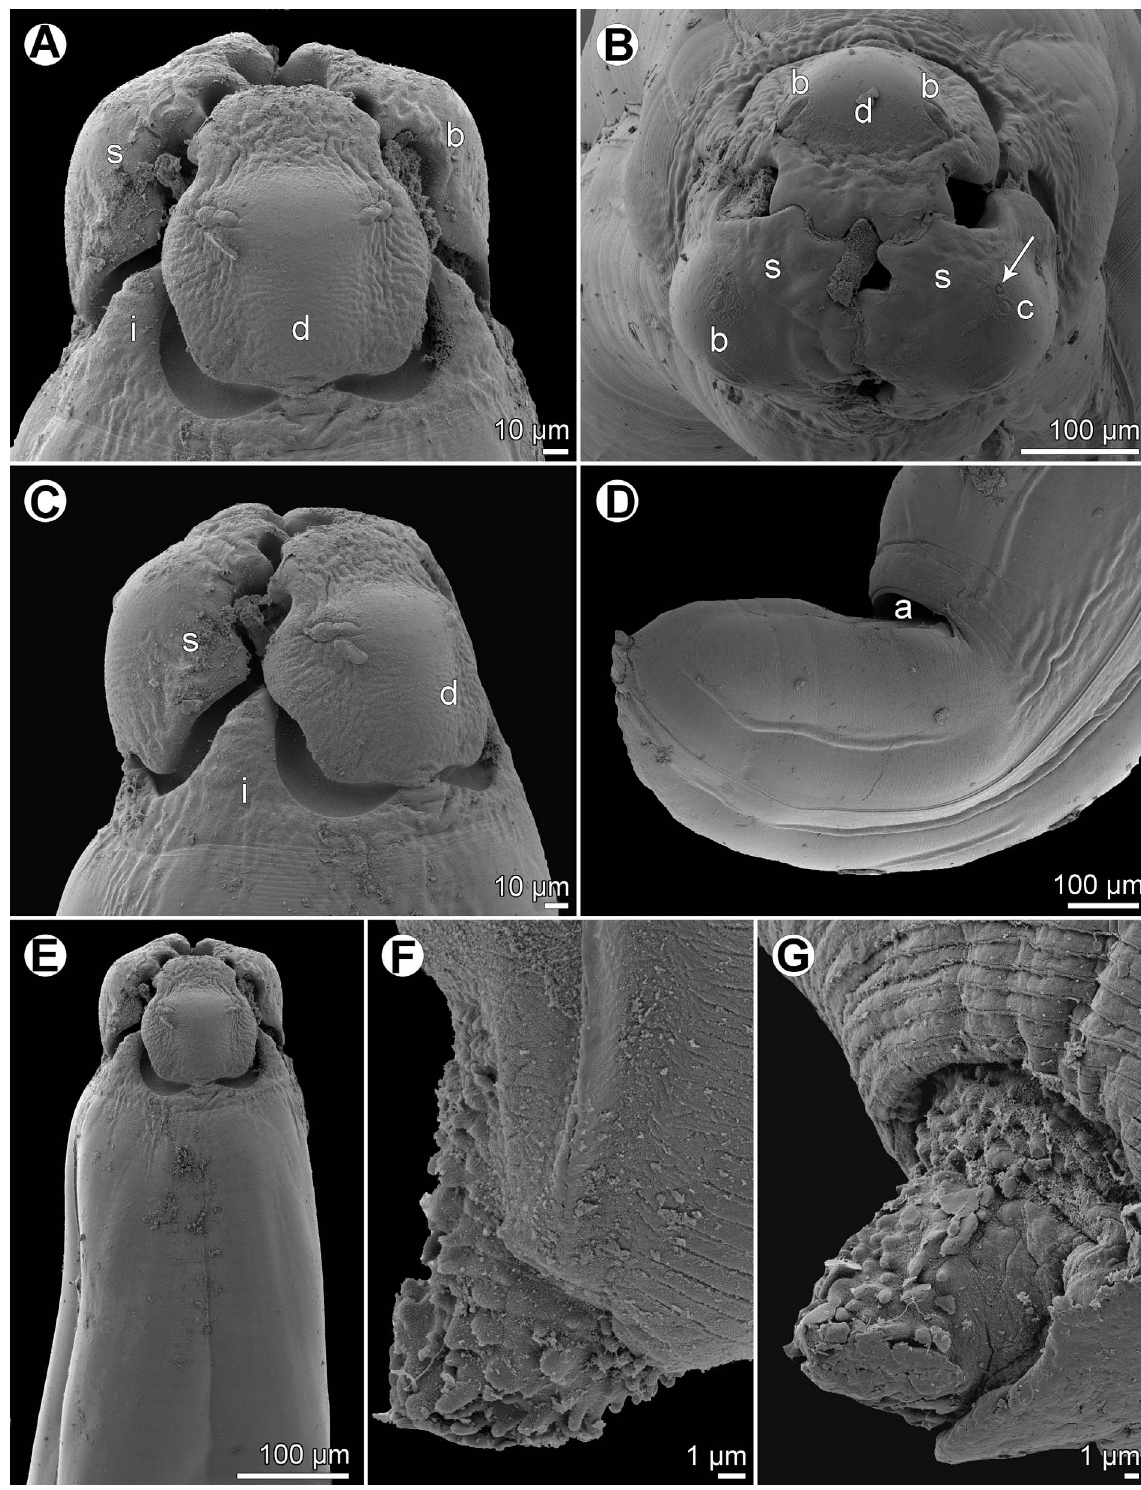
Figure 16. Hysterothylacium epinepheli (Yamaguti, 1941), scanning electron micrographs. (A) Cephalic end, dorsal view; (B and C) cephalic end, apical and lateral views, respectively (arrow indicates amphid); (D) female tail, lateral view; (E) anterior end of body, dorsal view; (F) tail tip of male, lateral view; (G) tail tip of female, lateral view. (a) Anus; (b) labial double papilla; (c) labial single papilla; (d) dorsal lip; (i) interlabium; (s) subventral